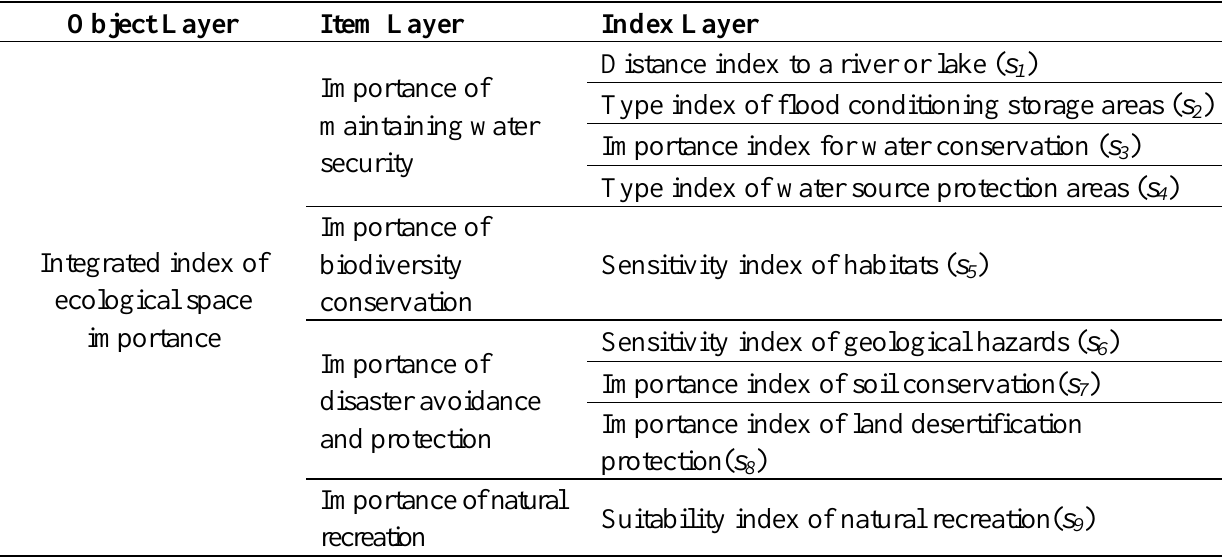
Table 1. Evaluation index system for ecological space importance.